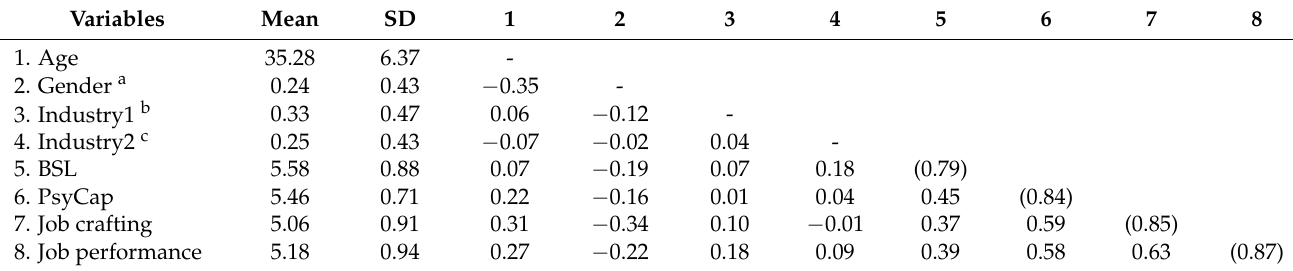
Table 2. Descriptive statistics and correlation